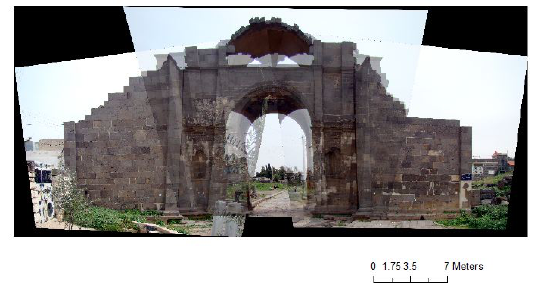
Figure 8. Photomosaic of the Western Gate using GaiaOrtho free software